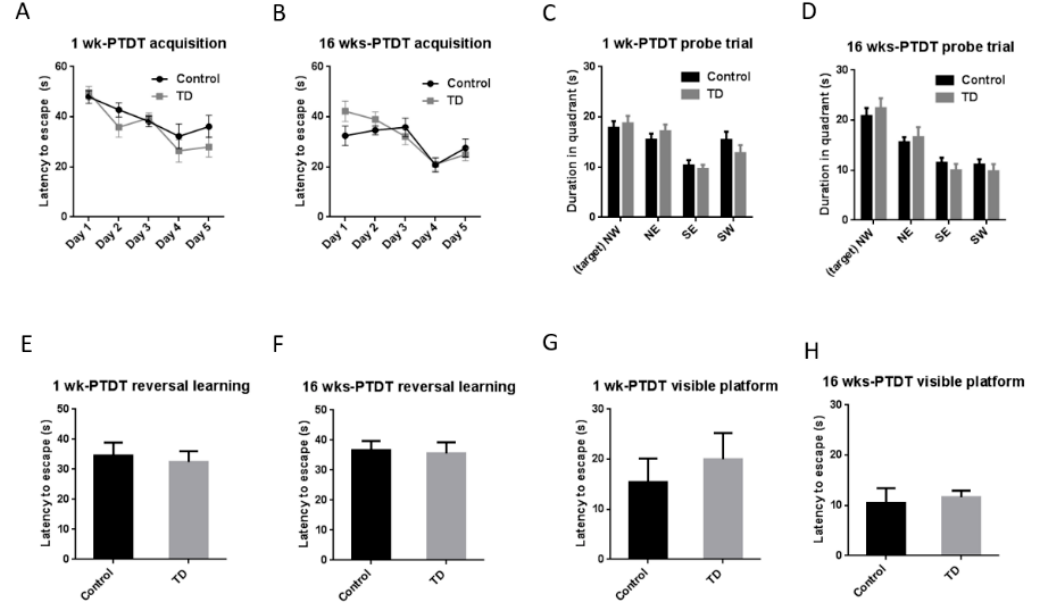
Figure 6. The results of the Morris water maze (MWM) test of the two cohorts after TD treatment. The acquisition time in the 1 wk-PTDT cohort ( A ) and the 16 wks-PTDT cohort ( B ); the duration in each quadrant in the probe trial in the 1 wk-PTDT cohort ( C ) and the 16 wks-PTDT cohort ( D ) (NW: northwest quadrant where the platform was placed; NE: northeast; SE: southeast; SW: southwest); the latency to escape during reversal learning in the 1 wk-PTDT cohort ( E ) and the 16 wks-PTDT cohort ( F ); the latency to escape during the visible platform test in the 1 wk-PTDT cohort ( G ) and the 16 wks-PTDT cohort ( H ). For the 1 wk-PTDT cohort, n = 10 for both control and TD groups. For the 16 wks-PTDT cohort, n = 10 for the control group, and n = 9 for the TD group. The Graphpad Prism t -test and one-way repeated-measures ANOVA were performed when necessary.